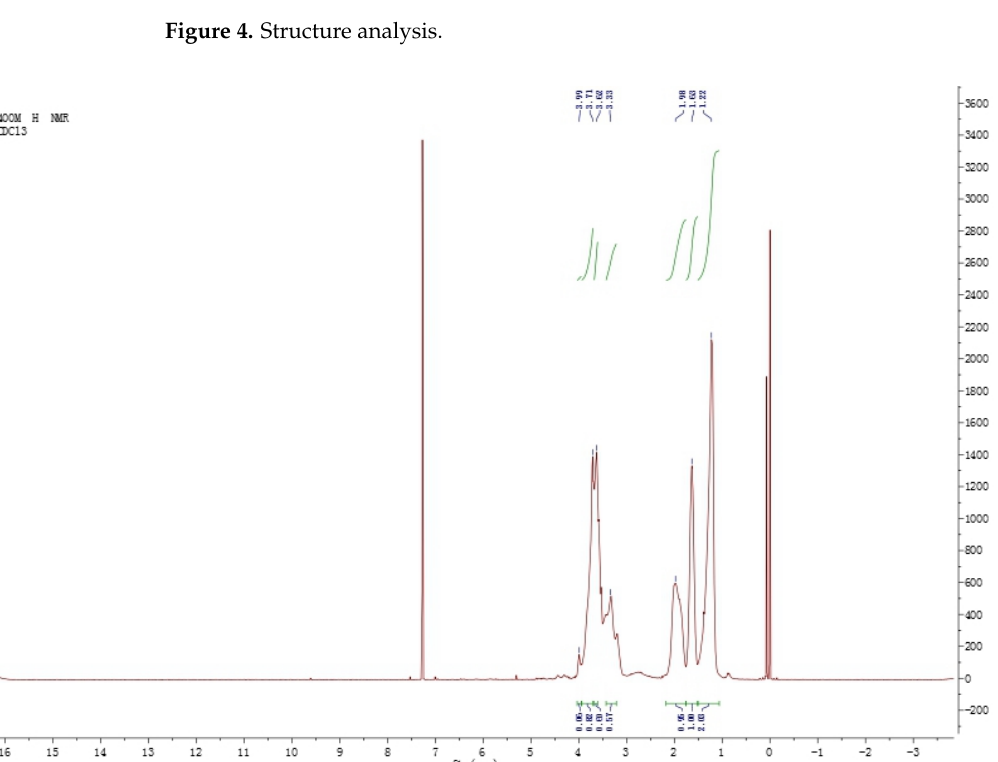
Figure 4. Structure analysis.